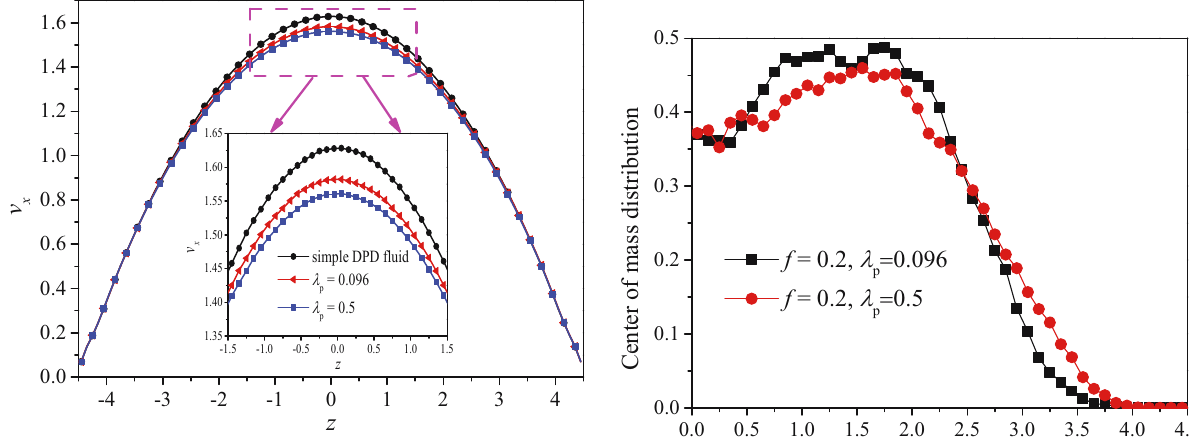
Figure 15: The velocity pro fi les across the slit under the driving force f = 0.1 for the wormlike chain solution with = λ 0.096 peff and 0.5, and for the simple DPD fl uid.